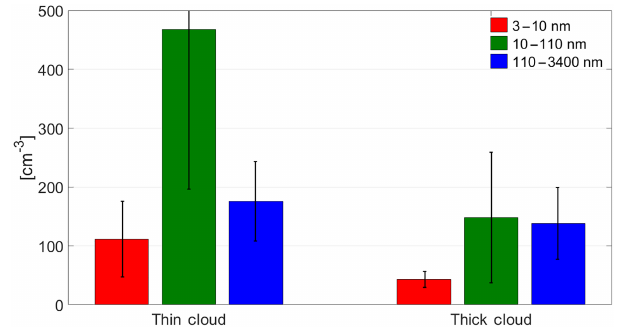
Figure 9. Particle concentrations in different diameter ranges (3–10, 10–110, and 110–3400nm) in the sub-cloud (SUB) layer for thin (thickness <333m) and thick (thickness ≥ 333m) clouds. Whiskers represent 1 standard